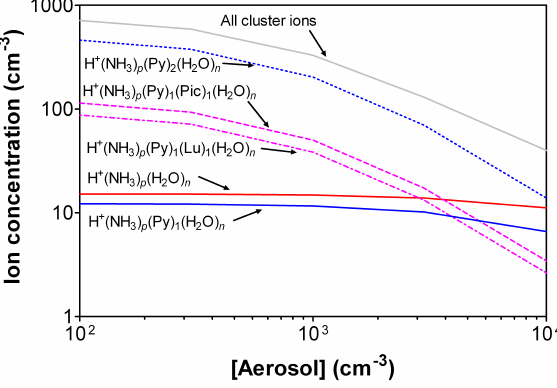
Fig. 10. Concentrations of the most abundant cluster ions as a func- tion of aerosol concentration. The values were calculated using Model A. The initial concentrations are given in Table 2 except the concentration of pyridine that was kept at 9.83 × 10 7 cm − 3 and the aerosol concentration that was